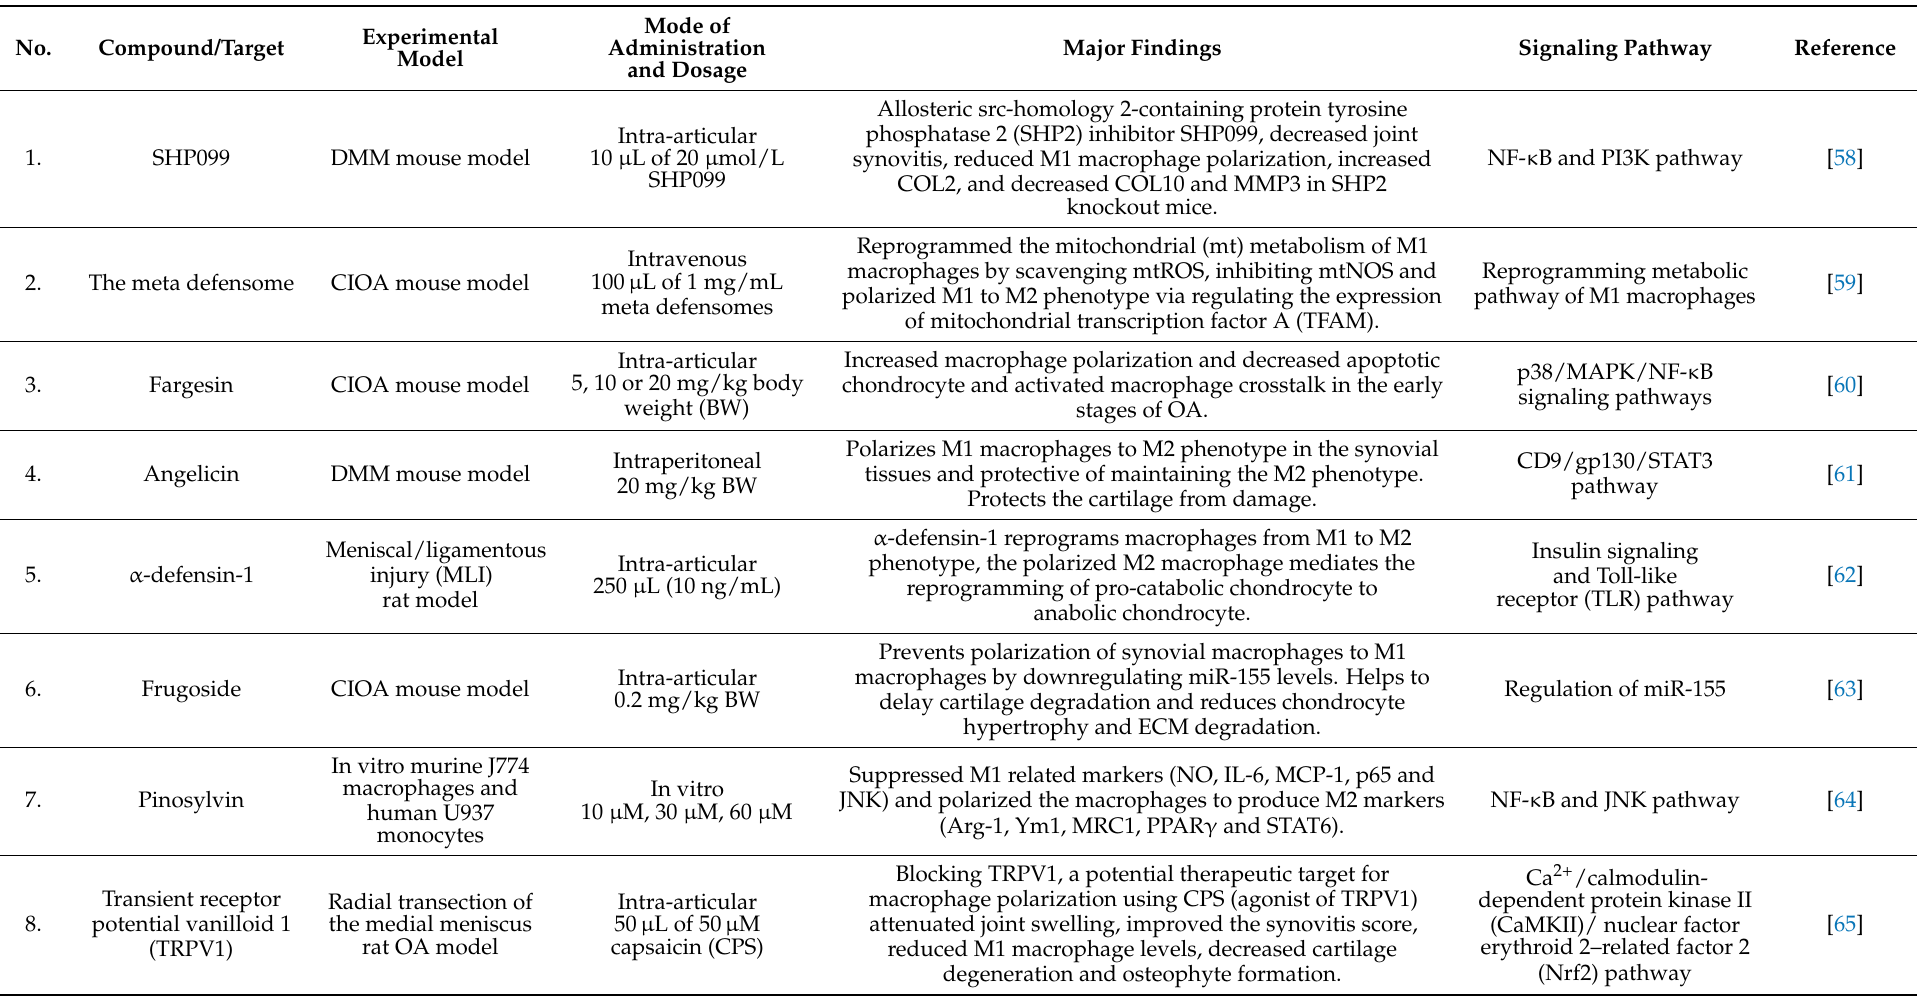
Table 1. Therapeutic strategies for macrophage